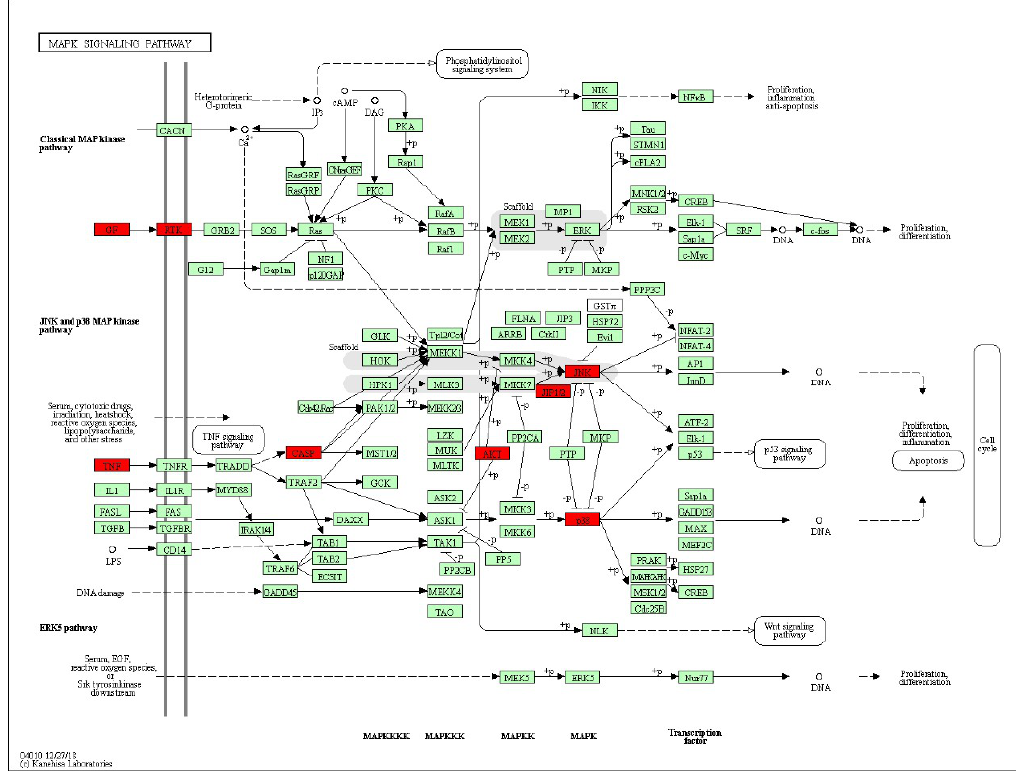
Figure 4. Representation of the targets of stemazole (ST) involved in the MAPK signaling pathway. The pathway maps were constructed using the KEGG mapper. The green rectangles and red rectangles represent unidentified proteins and identified proteins, respectively.